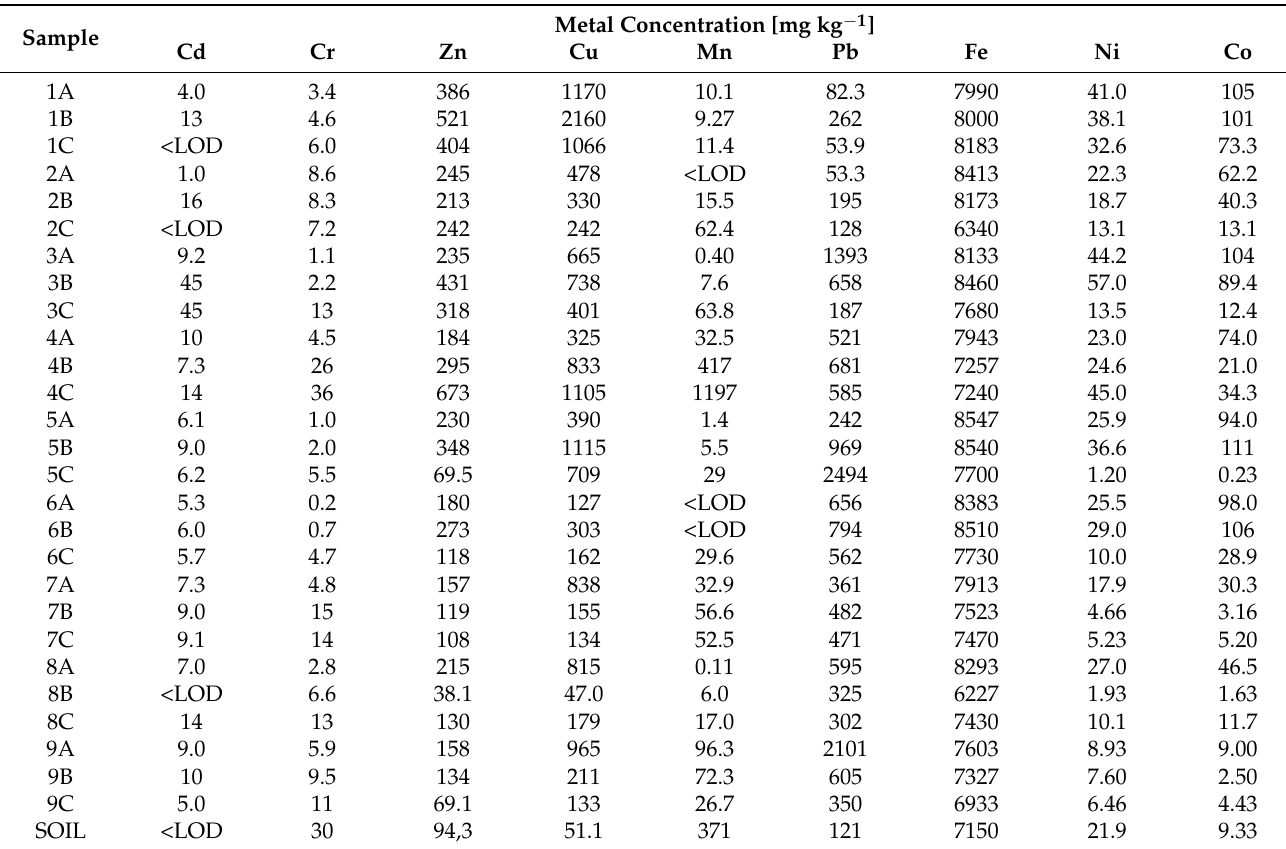
Table 3. The results of the determinations of the heavy metals concentrations in the samples collected from the B ă iut mining area. ,